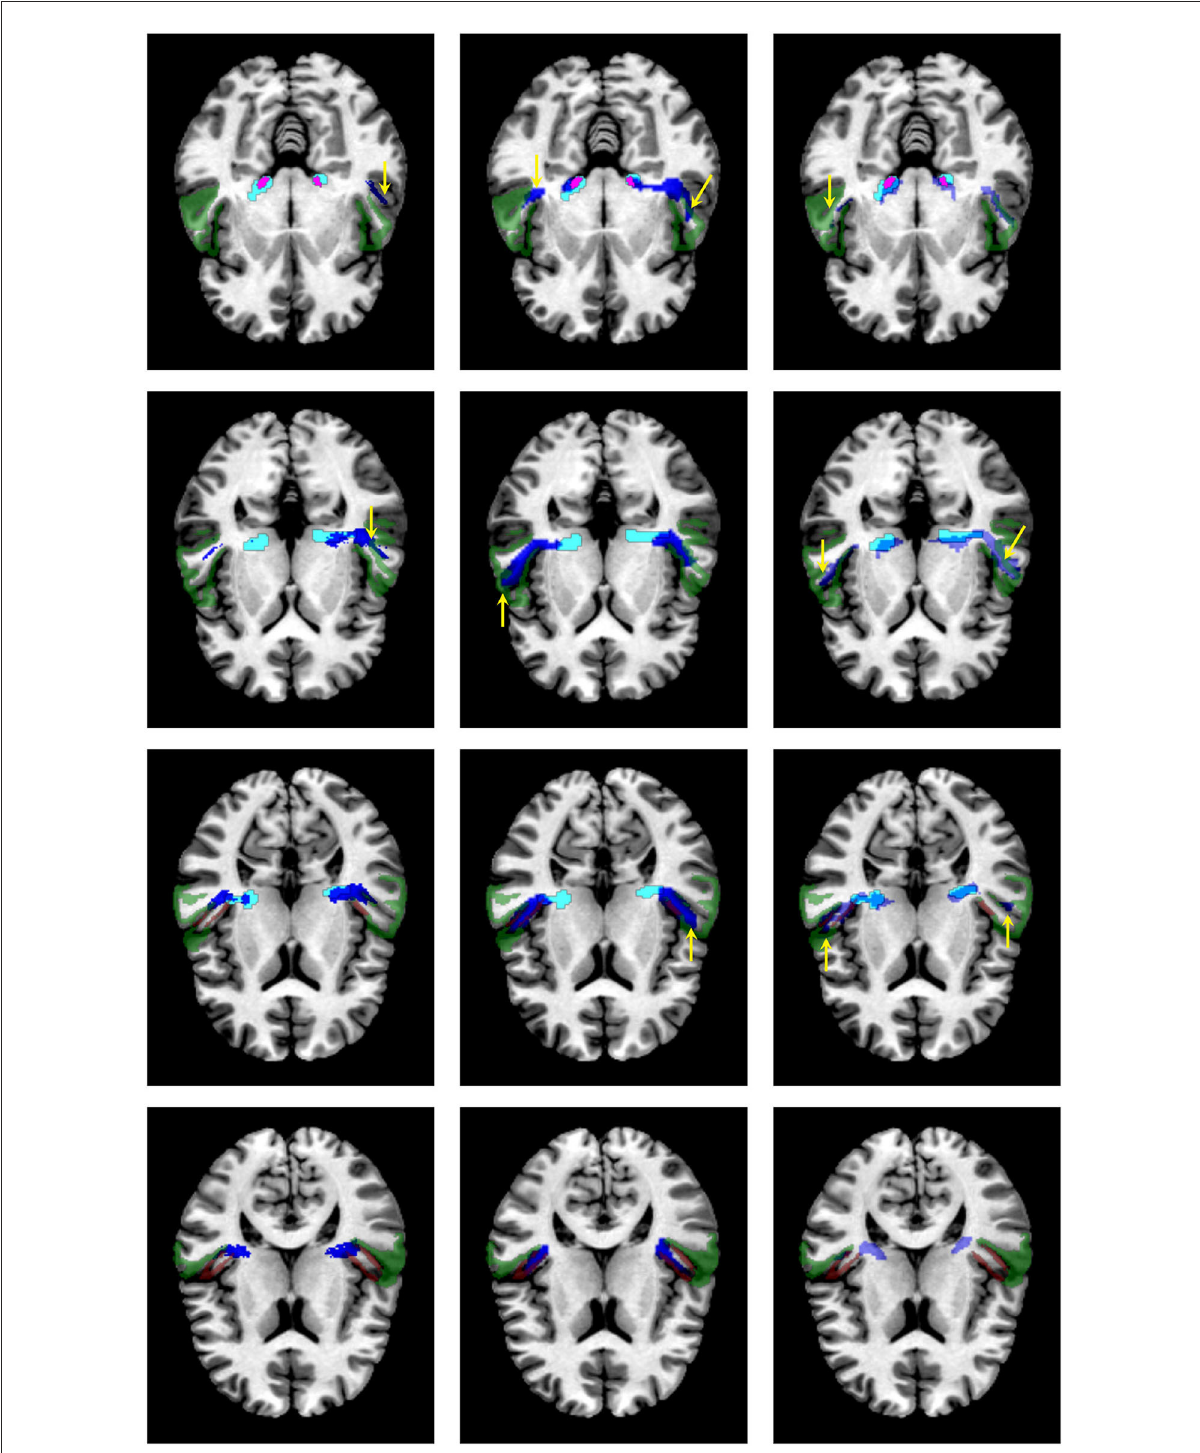
FIGURE8 Visual comparison of the segmentation masks on one subject of the clinical dataset. First column: segmentation mask of the proposed methodology (in cyan) and the atlas by Maffei et al. (16) (in blue). Second column. segmentation mask of the proposed methodology (in cyan) and the atlas by Bürgel et al. (2) (in blue). Third column: segmentation mask of the proposed methodology (in cyan) vs. the result from XTRACT (in blue). Every row corresponds to a different axial slice. The superior temporal gyrus (STG), medial geniculate nucleus, and Heschl’s gyrus are depicted in green, magenta, and brown, respectively. Yellow arrows indicate where the segmentation masks reach the